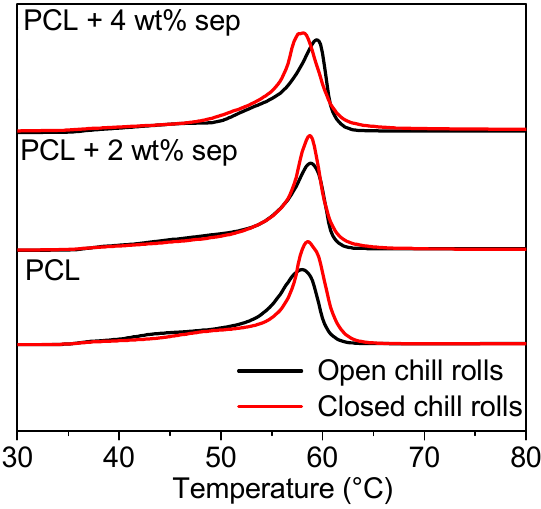
Figure 6. Melting peaks from the first heating run of DSC experiments. The solid black lines represent samples obtained with open chill rolls (slow cooling) and the red lines are for samples obtained with closed chill rolls (rapid cooling), indicating a higher degree of crystallinity for the latter.